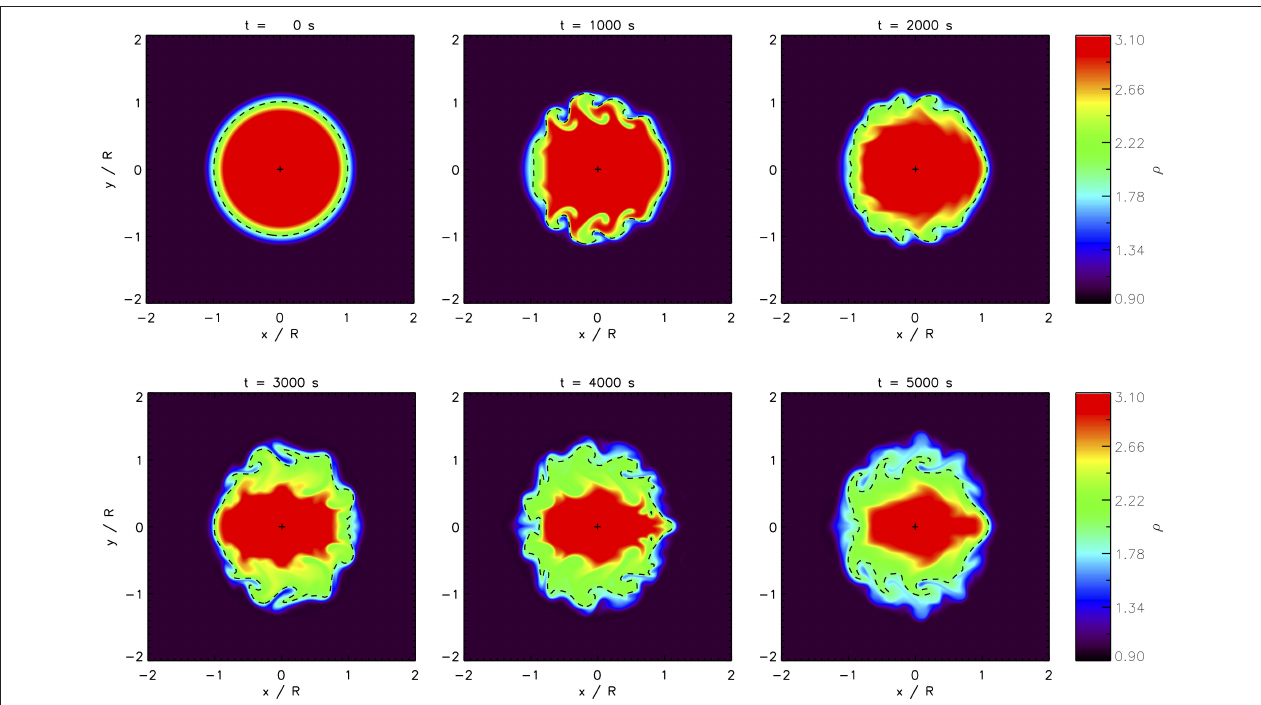
FIGURE 1 | Evolution of the loop density profile in time. The panels show the density in normalized units at the middle ( z = 50 Mm) of the coronal loop. The cross symbols denote the position of the loop. The dashed line represents the contour for which the local Alfvén speed matches the kink speed.